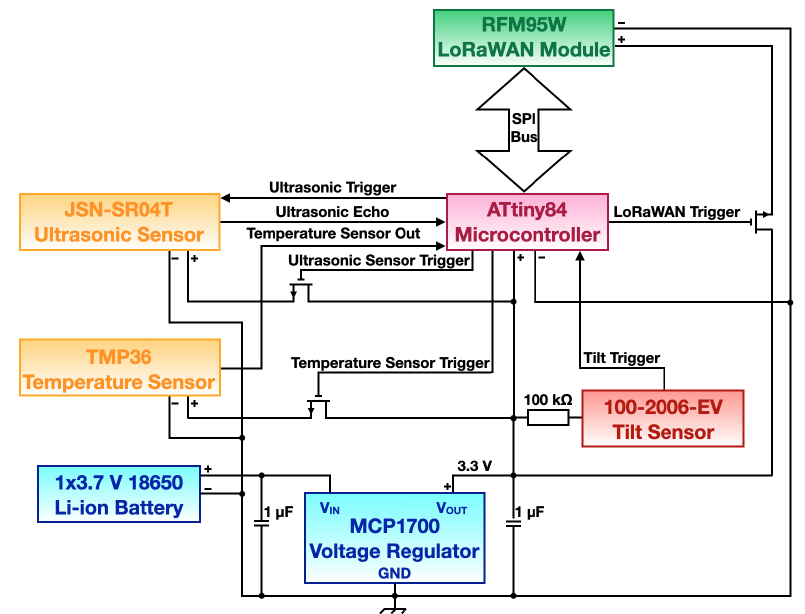
Figure 2. Smart bin block